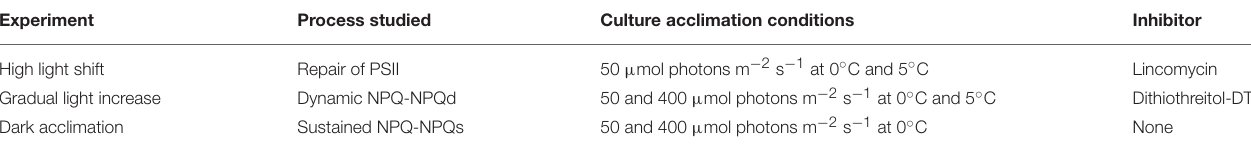
TABLE 2 | Description and conditions of targeted